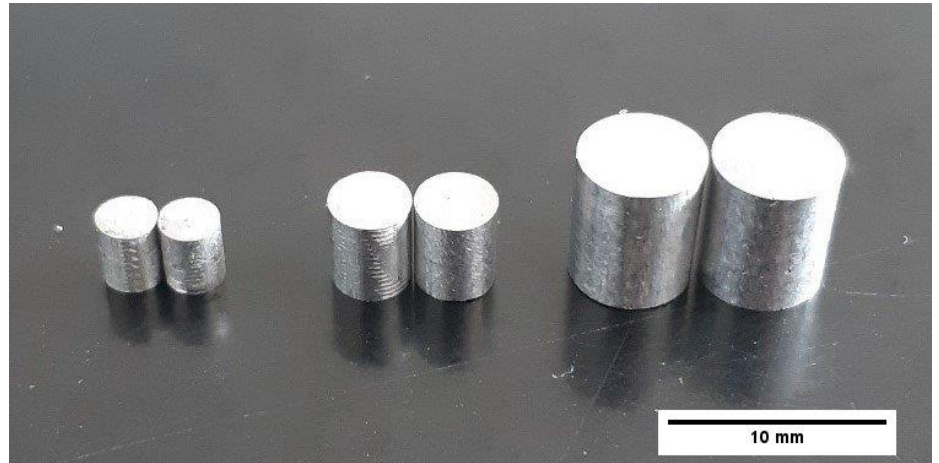
Figure 3. Macro photograph of specimens with different sizes (small, medium, large) in direct correlation with the wall thickness of the castings used for compressive testing.